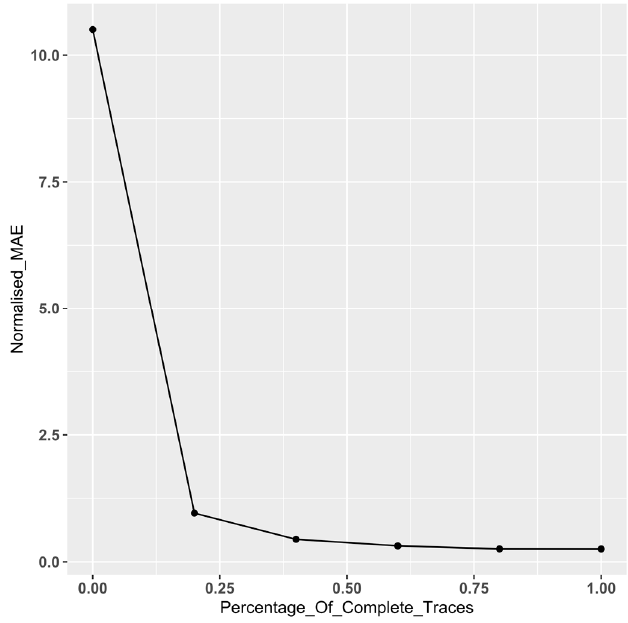
Figure 8. BPIC 18—Normalised MAE by proportion of incomplete traces.